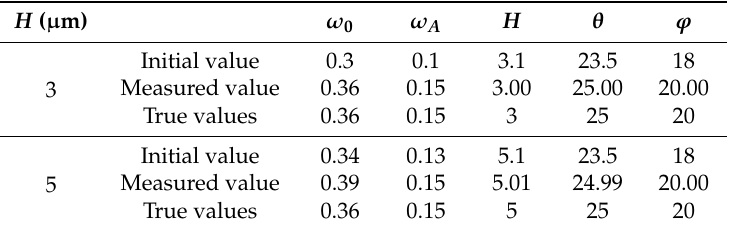
Figure 4. Measured Mueller matrix spectra (blue) and fitted Mueller matrix spectra (red) for the volume gratings whose dielectric constant is a continuous sinusoidal distribution, with thicknesses of ( a ) 3 µ m and ( b ) 5 µ m, respectively. Table 3. Simulation results of case 3.